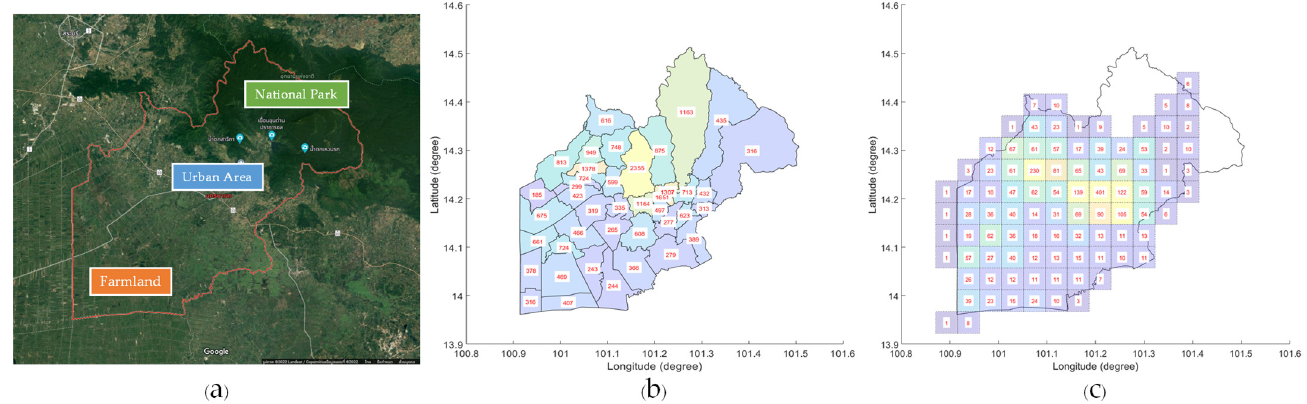
Figure 7. ( a ) Map of Nakhon Nayok, ( b ) number of registered passenger cars ( ≤ 7 seats) of each subdistrict, and ( c ) estimated number of electric passenger cars ( ≤ 7 seats) of each cell.